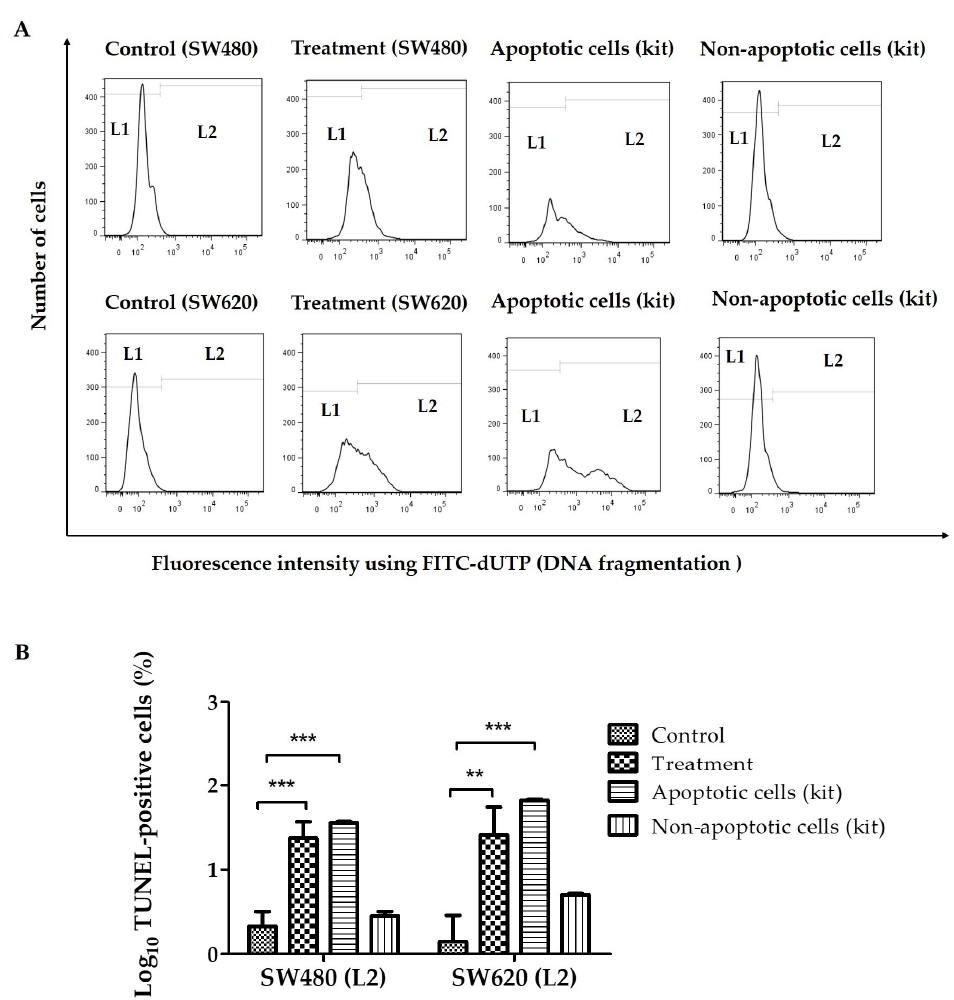
Figure 1. Effect of an aqueous extract of lyophilized mango pulp (LMPE) on DNA fragmentation in SW480 and SW620 cell lines. The cells were exposed to 30 mg LMPE/mL for 48 h. Untreated cells (0 mg LMPE/mL) were used as a control. The kit used has apoptotic cells (positive control) and non-apoptotic cells (negative control). Representative histograms of fluorescence intensity using fluorescein isothiocyanate (FITC)-dUTP (detected by flow cytometry) in SW480, SW620, apoptotic (positive control), and non-apoptotic (negative control) ( A ) cells. TUNEL-negative cells (with lower DNA fragmentation) are located in L1 and TUNEL-positive cells (with higher DNA fragmentation) are in L2. Log 10 of the percentage of TUNEL-positive cells (located at L2) ( B ). Data were expressed as mean ± SEM ( n = 3). ANOVA test was performed to compare the groups; p < 0.001 for both cell lines. Differences between the group mean and control group was analyzed by Dunnett’s post hoc test; significant differences were expressed as ** p < 0.01 and *** p <